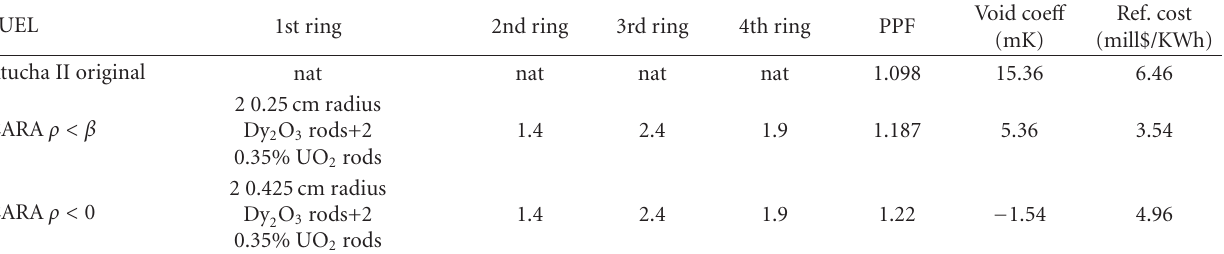
Table 4: Main results obtained for CARA fuel in Atucha II with safe coolant void coe ffi cient compared with the original Atucha II fuel bundle.